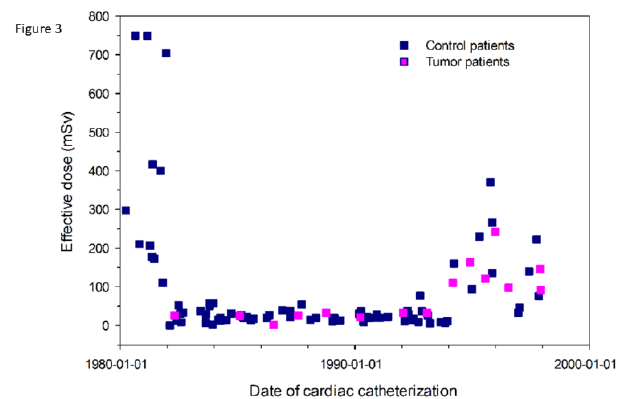
Figure 3. Effective radiation dose in 60 controls (blue dots) without cancer disease and 15 patients (orange dots), who developed cancer until the age of 15 years after cardiac catherization (CC) in the first year of life. Effective radiation dose is plotted against time at cardiac catherization.